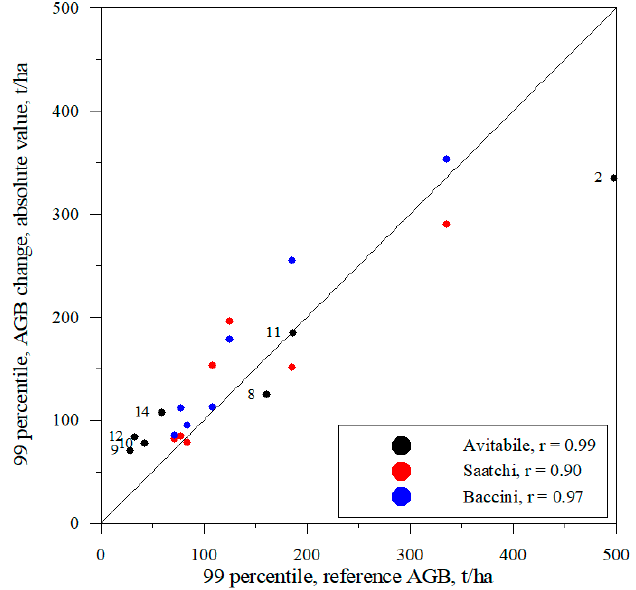
Figure 8. The 99th percentile of Δ AGB for seven land cover classes plotted against the corresponding 99th percentile of the AGB stocks based on [11,12,15]. The land cover types are given as labels for the points of [15], where the numbers correspond to land cover types as given in Table 5.